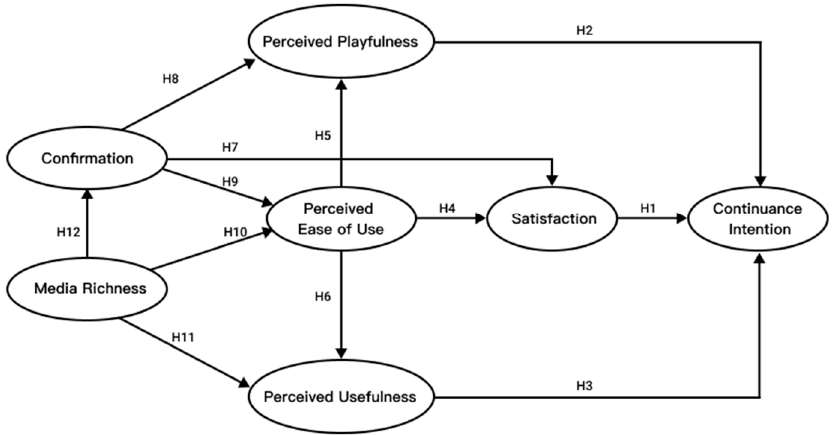
Figure 2. Proposed research model.